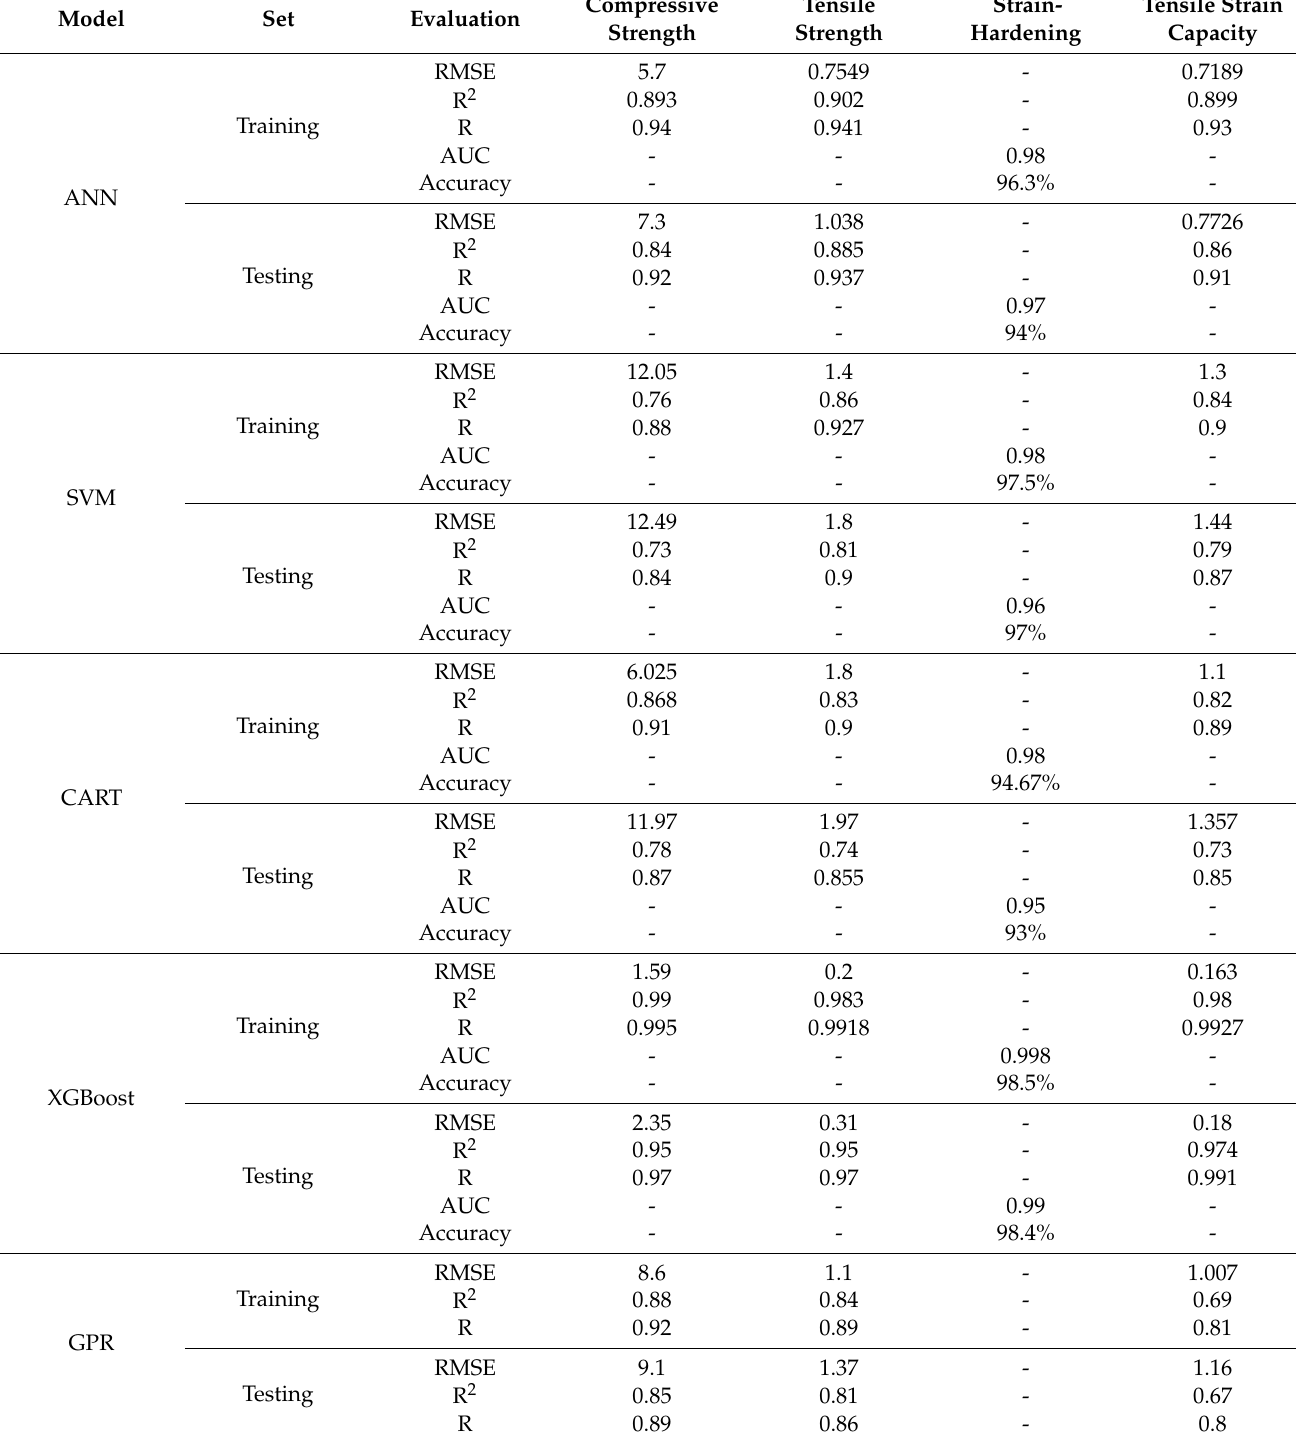
Table 6. Evaluation of predicted